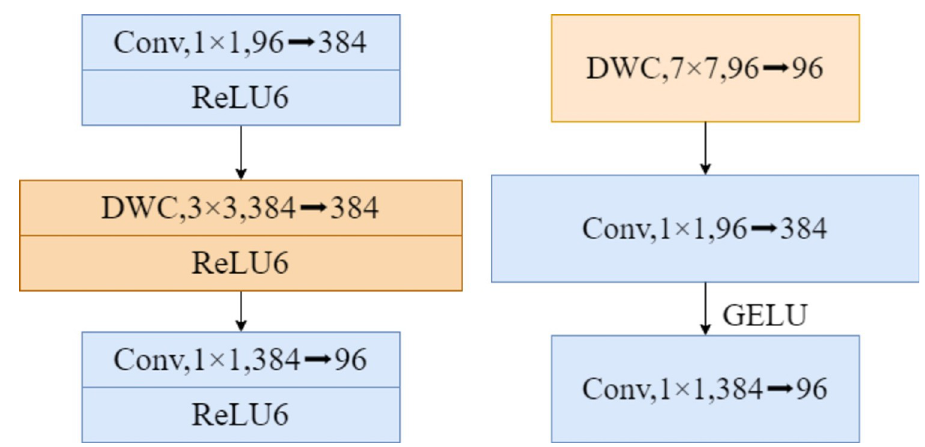
Fig 7. Structure of Inverted bottleneck before and after